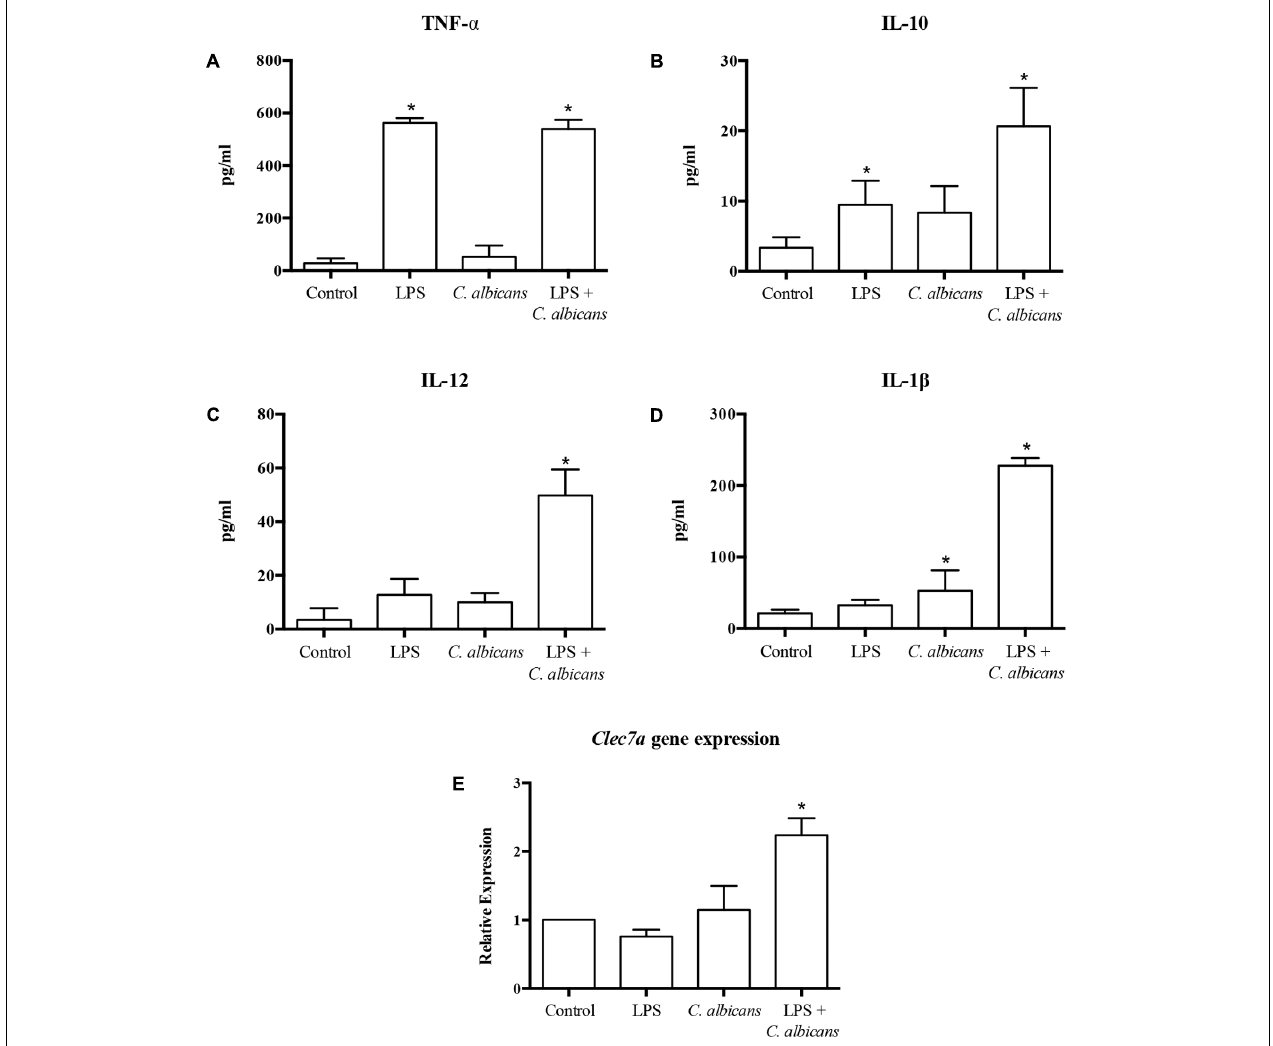
FIGURE 2 | Cytokine production [TNF- α (A) , IL-10 (B) , IL-12 (C) , and IL-1 β (D) ], and transcription of CLEC7A (E) by macrophages challenged with LPS, C. albicans , or pretreated with LPS and challenged by C. albicans (LPS + C. albicans ). Control group had neither challenge nor pretreatment. Data are presented as mean ± SD of three independent experiments. ∗ p <